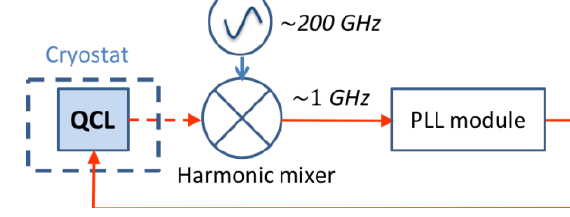
Fig. 3. Simplified block-diagram of QCL phase-locking shown in [17], [18], [19] and